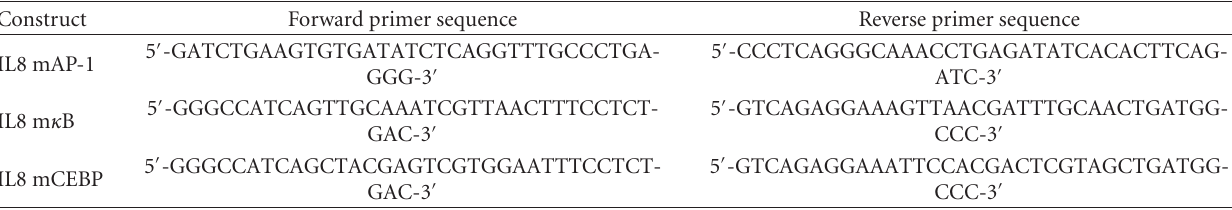
Table 1: Primers used in site-directed